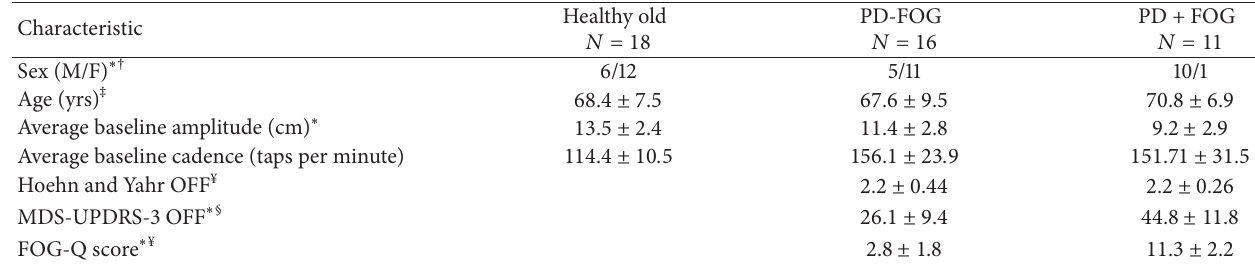
Table 1: Final sample